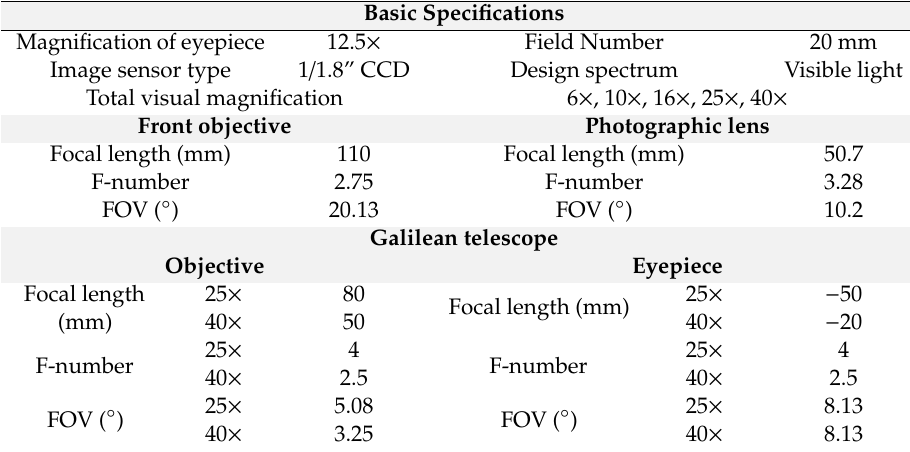
Table 1. Design specifications of the DSLM.